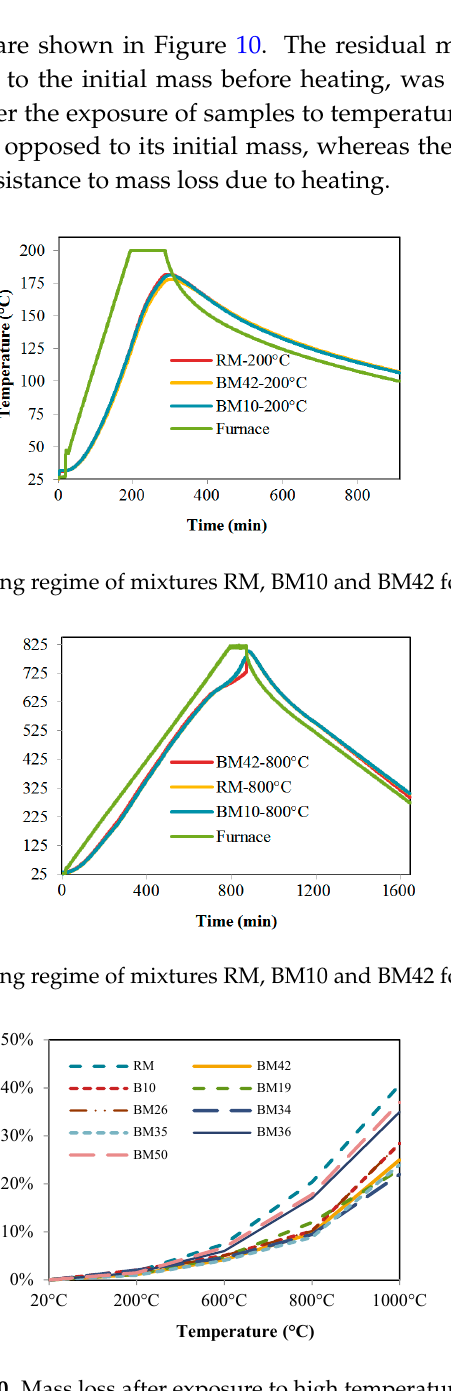
Figure 10. Mass loss after exposure to high temperatures.